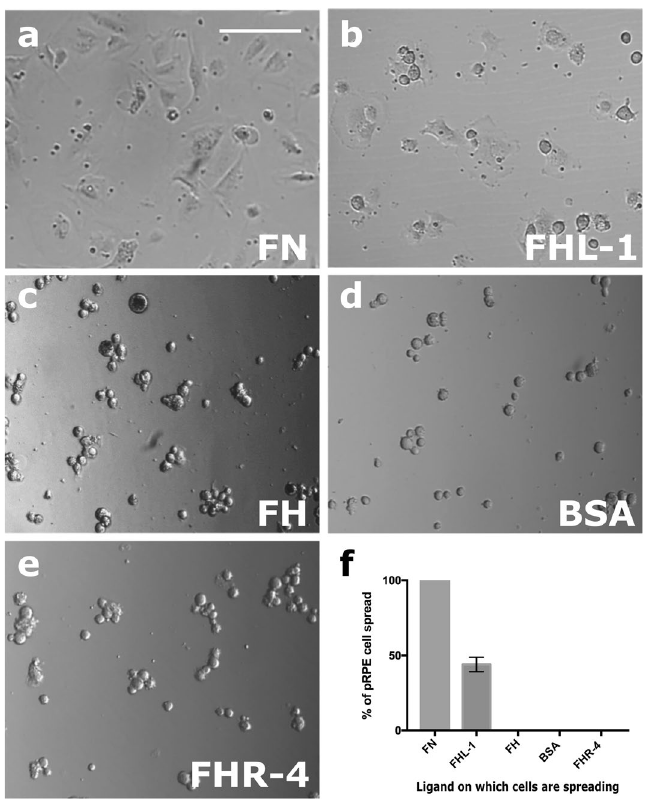
Figure 2. Primary RPE cells interact with immobilised FHL-1. Cultured primary RPE cells collected from human donor eyes were seeded at the same density (10,000 cells/well) in the wells of 96-well plates coated with: ( a ) FN; ( b ) FHL-1; ( c ) FH; ( d ) BSA; or ( e ) FHR-4. ( f ) the number of spread cells were counted in four different visual fields for each condition and each condition was measured in triplicate. The percentage of spread cells were calculated and compared to the positive control, fibronectin. Data are the average results of ten independent experiments and each performed in triplicate. Images in a - e are representative of 10 independent experiments. Incubation was done for 3 h at 37 °C. Scale bar represents 100 μm. Data in f represent n = 10 ±